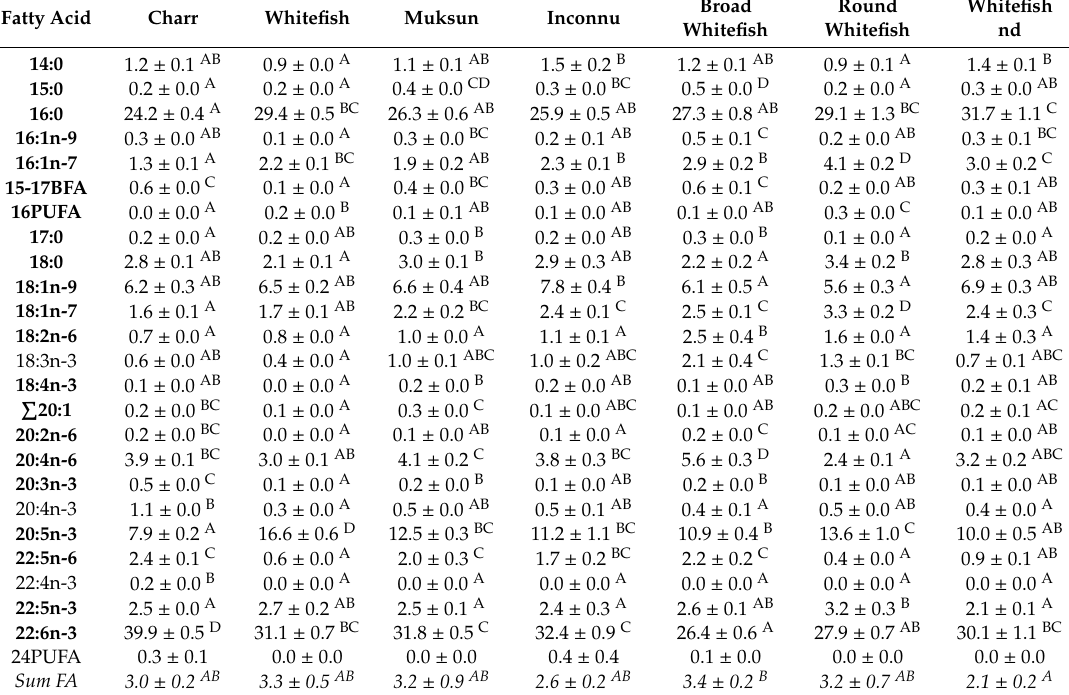
Table 4. Mean levels of fatty acids (% of the total) and total content of fatty acids (Sum FA, mg g − 1 wet weight) in polar lipids of Salmoniformes species: charr— S. drjagini from Sobachye Lake; whitefish— C. lavaretus from Sobachye Lake; muksun— C. muksun from Pyasino Lake; inconnu— S. leucichthys nelma from Pyasino Lake; broad whitefish— C. nasus from Pyasino Lake; round whitefish— P. cylindraceum from Sobachye Lake; whitefish nd—the non-identified form of C. lavaretus from Sobachye Lake. Cases (fatty acids) with normal distribution are given in bold. Means labeled with the same letter are not significantly di ff erent at P < 0.05 after ANOVA post hoc Tukey HSD test (cases with normal distribution) or Kruskal–Wallis test. If ANOVA is insignificant, letters are